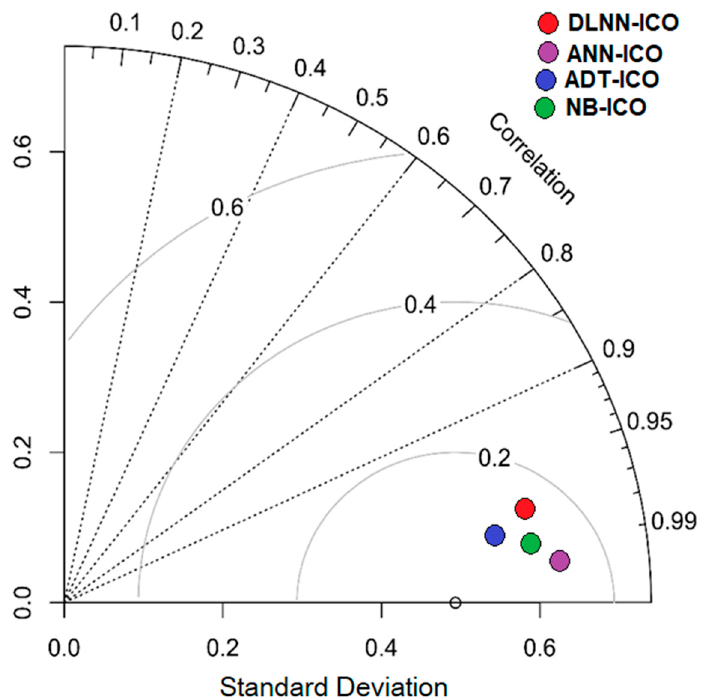
Figure 8. Taylor diagram.